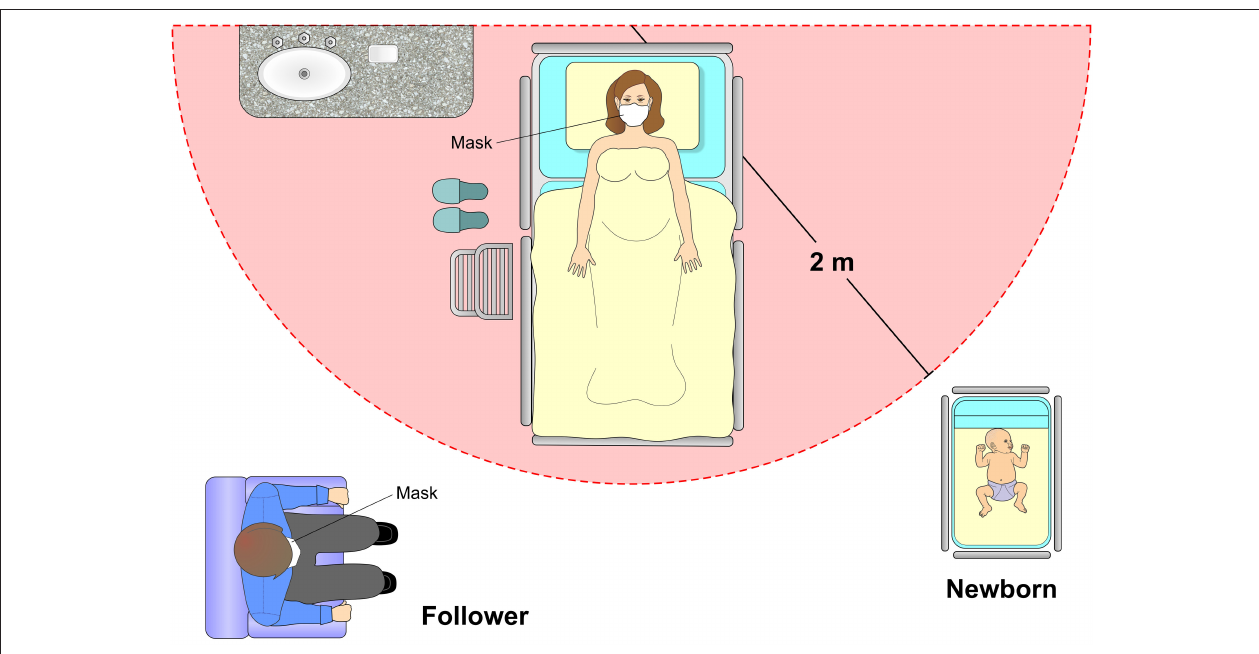
FIGURE 10 | Postpartum care. If the mother is in good health condition and does not require intensive care, it is recommended that the newborn remain in an appropriate cradle at a distance of 2 meters from the mother. The puerperal woman must always remain with a protective mask with an adequate filtering index and obey strict methods of hand hygiene. The presence of a companion is also allowed, following the rigor of hand hygiene with 70% alcohol and the use of an appropriate mask.